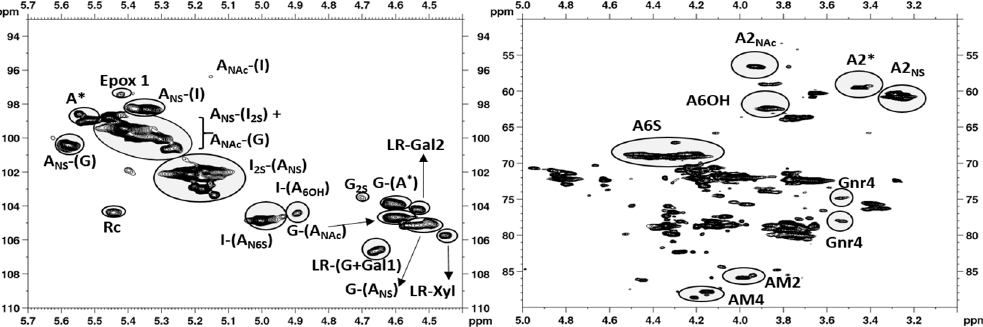
Figure 1. Anomeric (left) and ring (right) regions of 1 H/ 13 C HSQC NMR spectrum of Frag-5. AM corresponds to aM.ol. Table 1. Percent content of variously substituted glucosamine and uronic acid residues in different disaccharide sequences of Fragmin ® samples, together with typical linkage region residues.